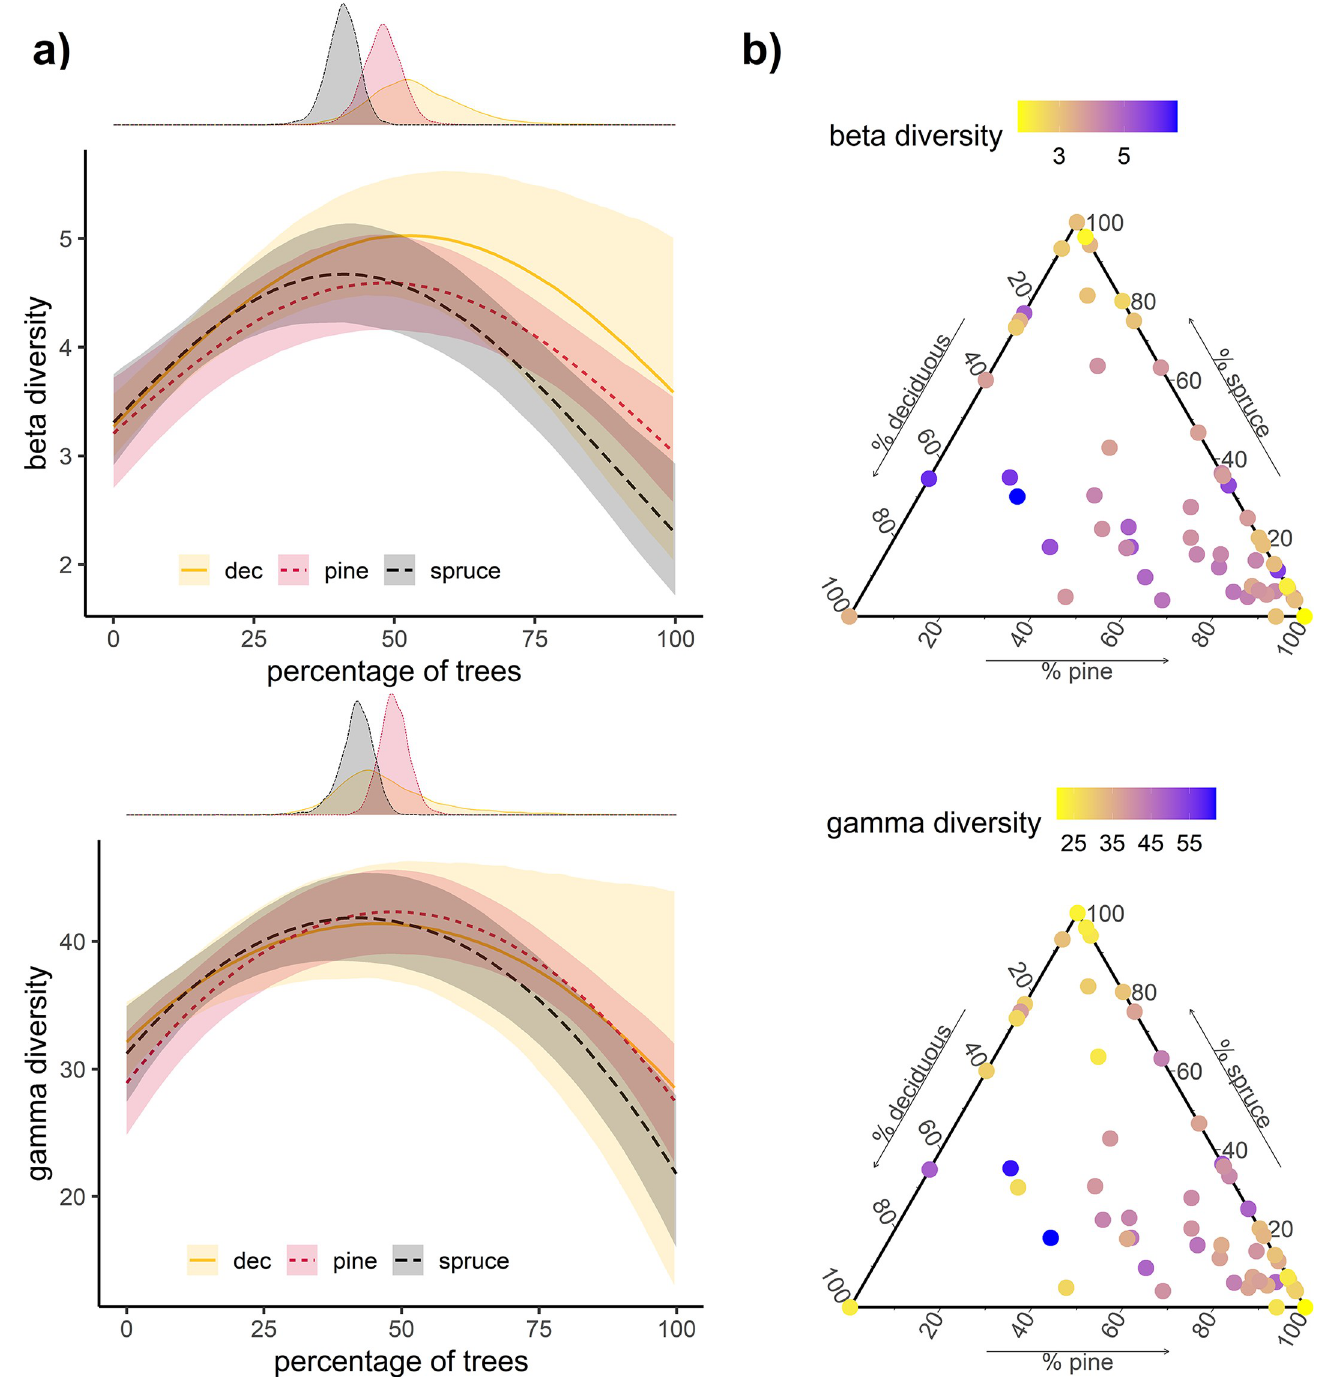
Fig 3. a) Stand level beta and gamma diversity is predicted with the percentages of Norway spruce, Scot’s pine or deciduous trees on a stand . This was done with three separate models but they are here combined for visual comparison (e.g. at 40% spruce nothing can be said about po9the tree species composition of the remaining 60% of the trees). The predictions are medians with the 95% credible intervals. The probability densities of the percentage of a tree species which is expected to result in the highest number of lichen species is presented above for all tree species groups. b) Ternary plot with the percentages of the tree species groups as the axis . The colours show predicted beta and gamma diversity for the tree species percentages that occurred on the studied subplots. The data on which this figure is based can be downloaded from https://doi.org/10.5281/zenodo.3899847. The data was originally created by Klein & Thor [39] and reused but not modified under the CC BY 4.0 license by